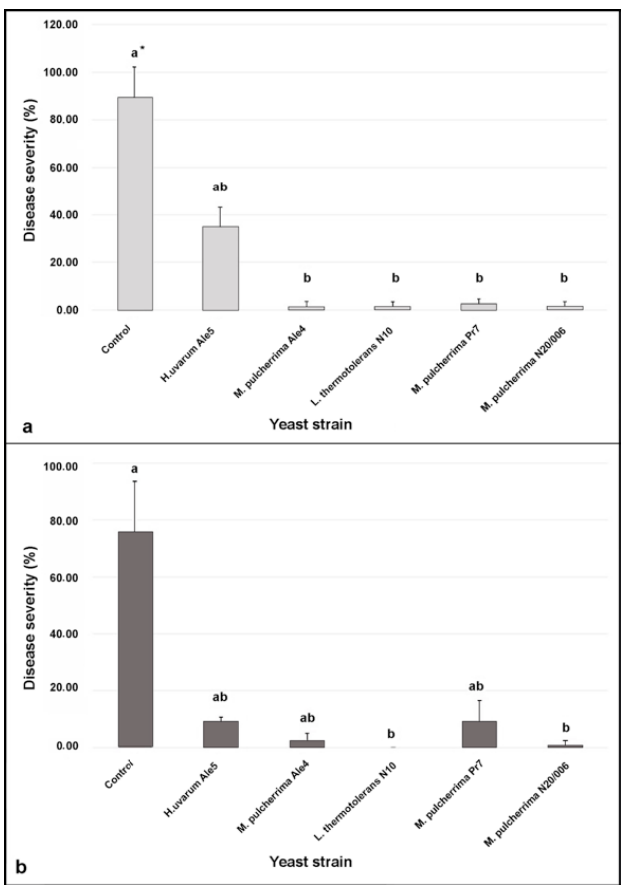
Figure 2. In vivo assay. In vivo antagonistic activity of yeast strains in inhibiting gray mold decay on wounded grape berries at two concentrations: ( a ) report effects of yeasts at 1.5 × 10 7 CFU mL −1 (white columns) and ( b ) report effects of yeasts at 1.5 × 10 4 CFU mL −1 (grey columns). Effects of yeasts refer to the disease severity caused by Botrytis cinerea 5 days after incubation at 25 °C. Data are presented as the mean of three replicates with standard deviation (vertical bars). * Columns within the same assay labeled by different letters are significantly different according to the Dunn’s test ( p < 0.05).